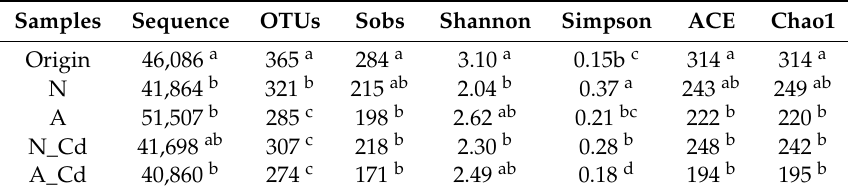
Table A1. Abundance and diversity of fungal and bacterial communities associated with the litter